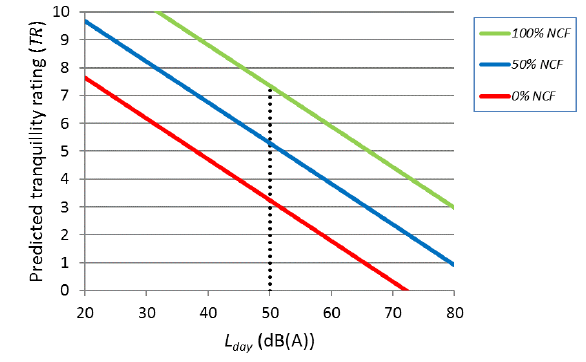
Figure 2: Linear variation of Tranquillity Rating (TR) with L day at levels of Natural and Contextual Features (NCF) of 0, 50 and